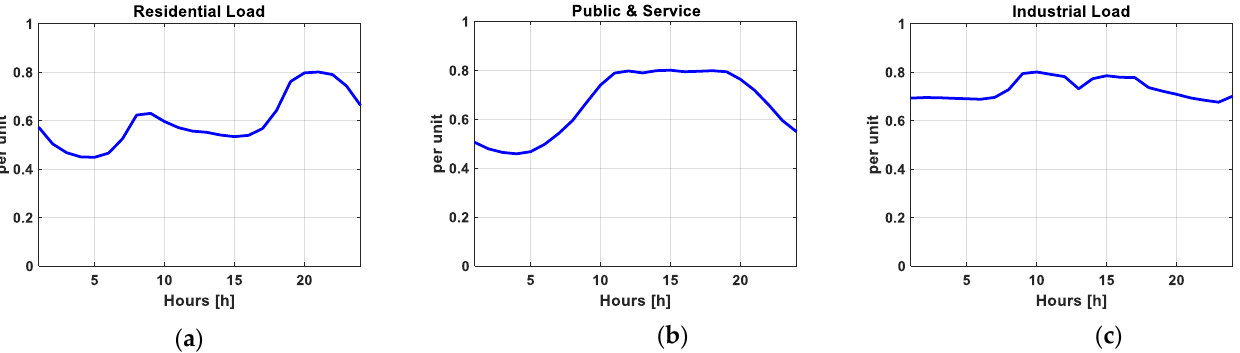
Figure 7. Load profile for each load type: ( a ) type I—residential load; ( b ) type II—public and service; ( c ) type III—industrial load . Table 1. Load type and locations.